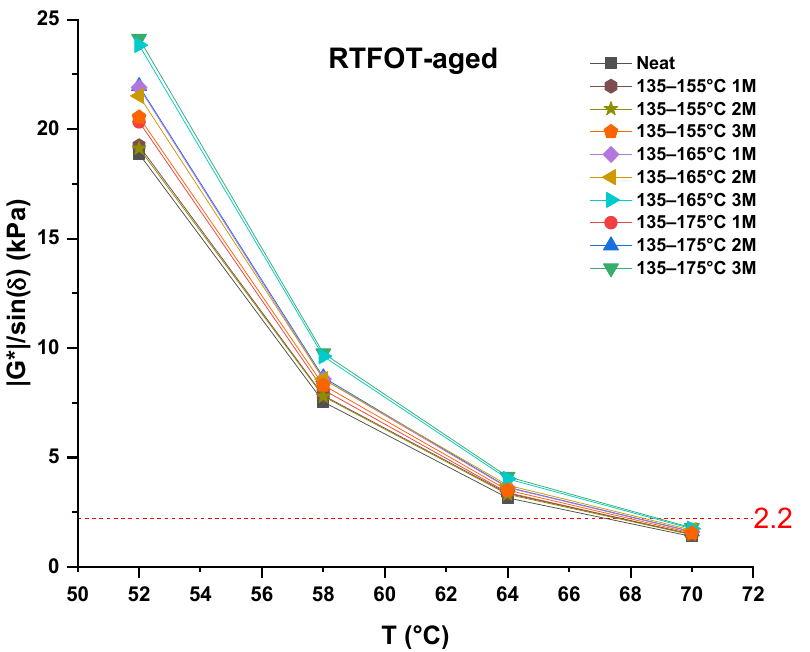
Figure 24. Rutting factor (|G* |/sin(δ) ) at the RTFOT-aged stage under different temperatures. In order to reduce rutting, the amount of work expended during each loading